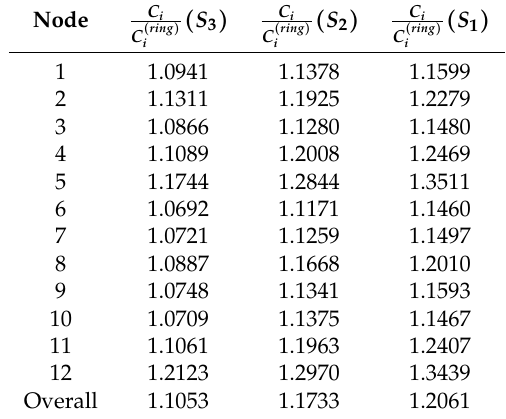
Table 2. Reliability gains (weightless optimization).